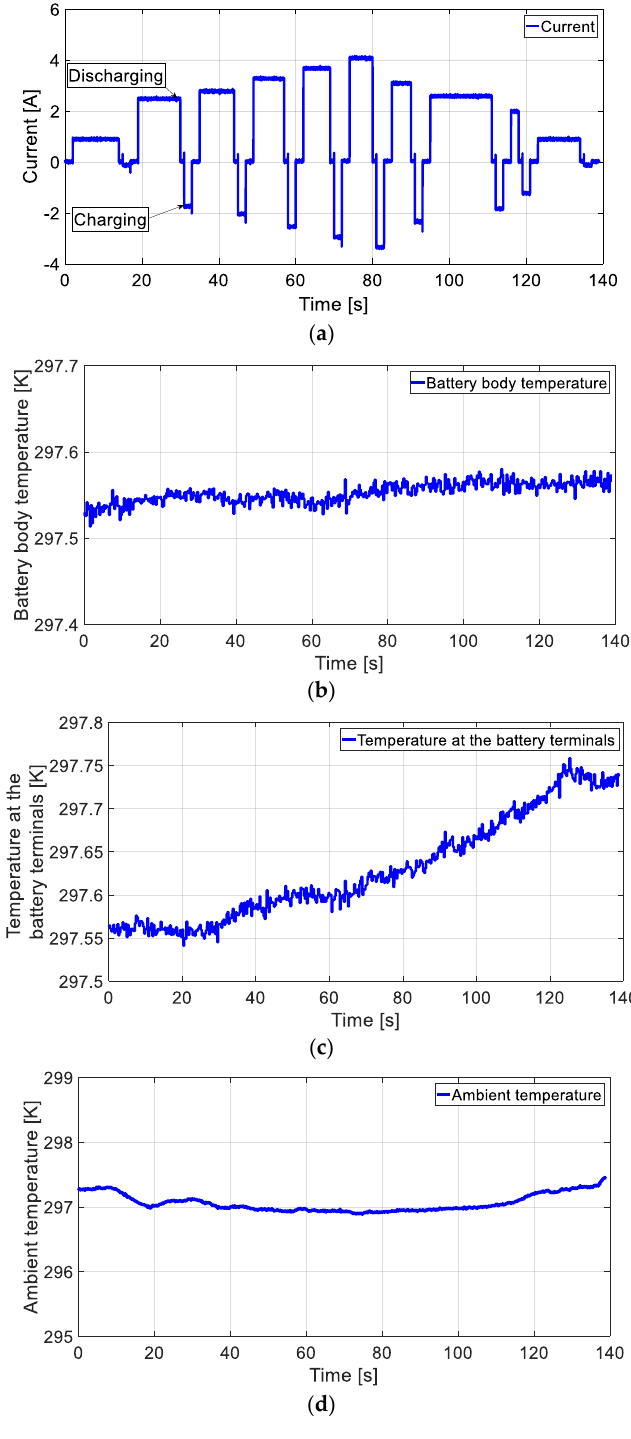
Figure 2. Plots of the: ( a ) Current in pulse cycle; ( b ) battery body temperature in pulse cycle; ( c ) temperature at the battery terminals in pulse cycle; ( d ) ambient temperature.